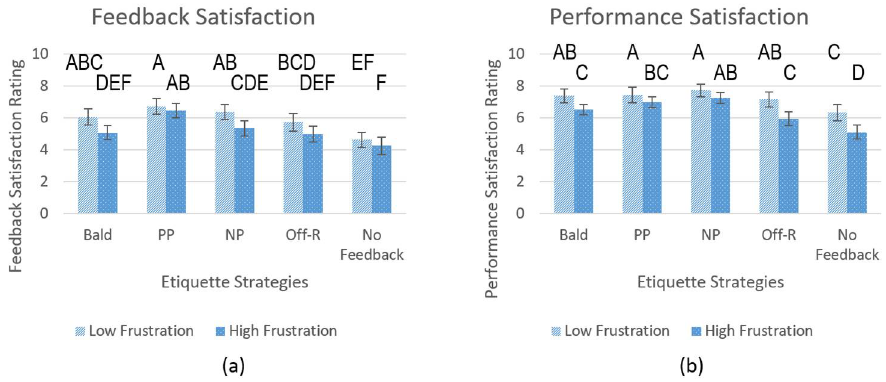
Figure 6. Mean and standard error of satisfaction with ( a ) feedback and ( b ) performance ( n = 40). Participants were significantly more satisfied with their own performance in low frustration than high frustration, F (1,39) = 33.6, p < 0.001, d = 0.31. The main effect of etiquette strategies